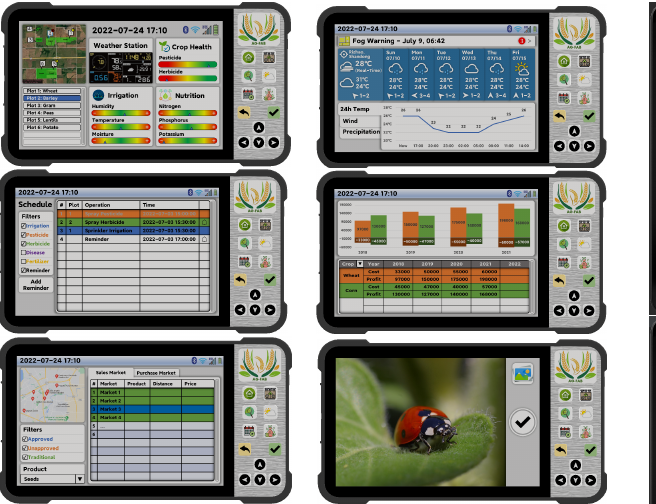
Figure 2. AgFAB Device Interfaces